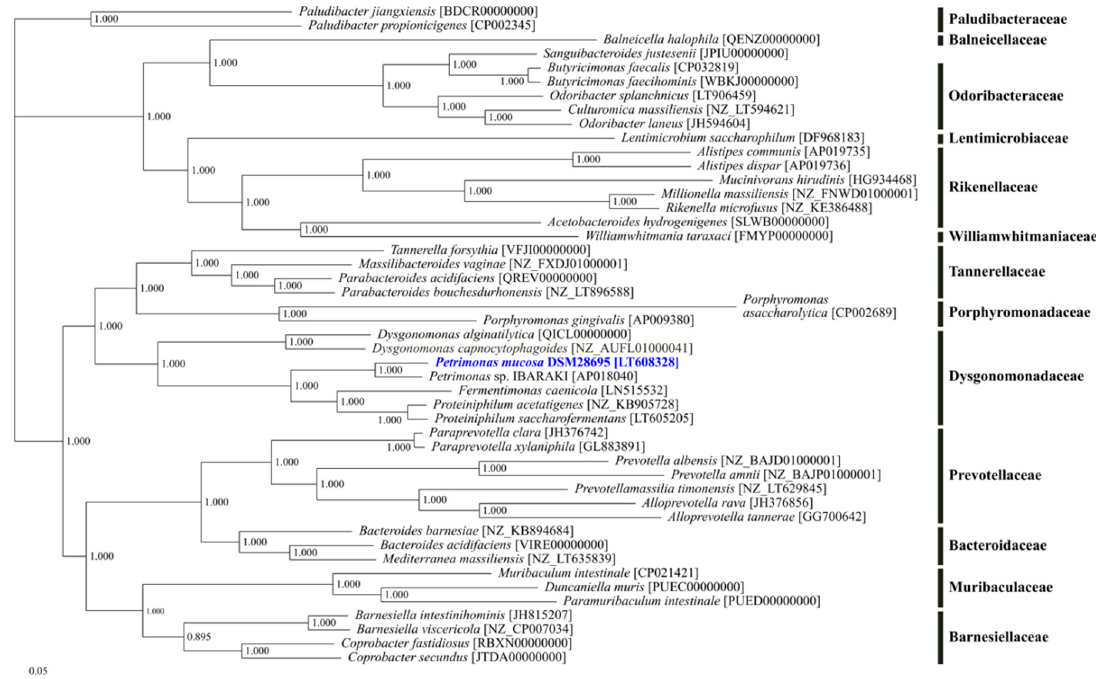
Figure 2. Phylogenetic tree of the order Bacteroidales. The phylogenetic tree is based on 94 core genes of the selected strains as determined by means of the comparative genomics tool EDGAR 2.0 [41]. Except for the metagenome assembled genome Petrimonas sp. IBARAKI [AP018040], genome datasets for type strains were used.